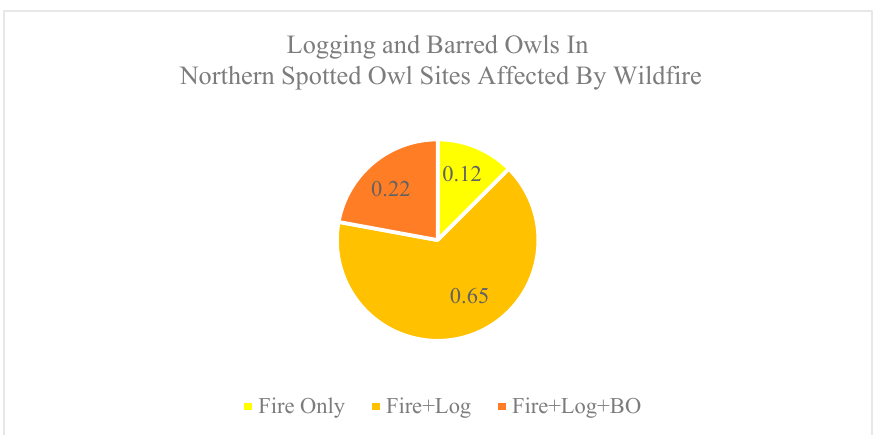
Figure 4. Proportion of Northern Spotted Owl sites that experienced severe wildfire and were not logged (fire only); that were also logged (fire + log), and that were logged and Barred Owls were detected (fire + log + BO).